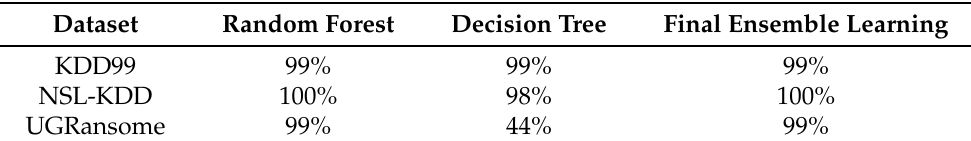
Figure 36. The prediction of the Decision Tree model. Table 12. The comparison of UGRansome with legacy datasets.